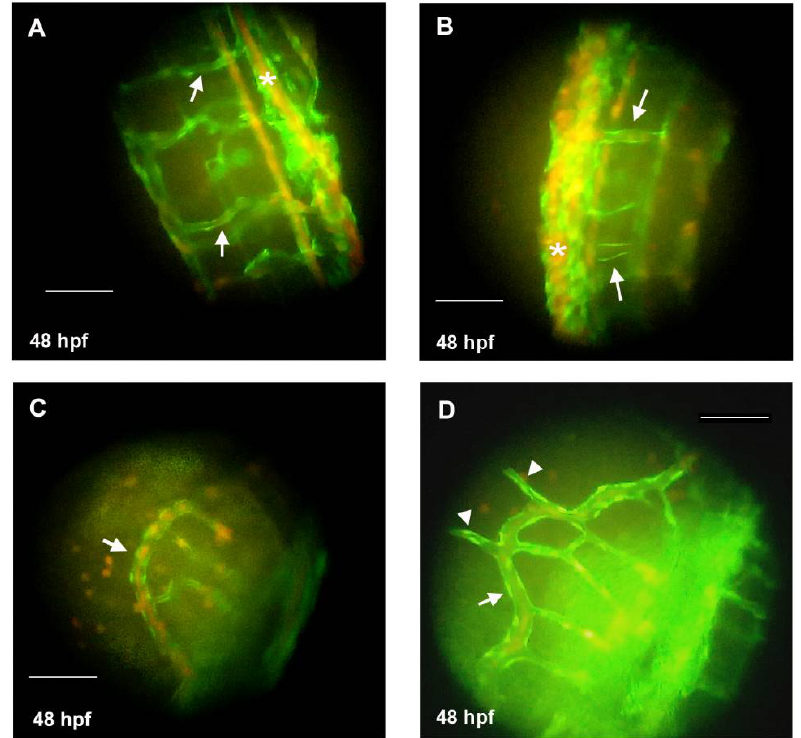
Figure 5. Knockdown of hyaluronan synthases 2 gene (HAS2) in zebrafish embryos leads to dilated venous structure. Tg ( fli1 : egfp ) xTg ( gata1 : dsRed ) zebrafish with green fluorescence emitting vasculature are used to observe the anatomic change of vasculature. ( A ) Inter-segmental veins (ISVs) in the tail of a representative wild-type zebrafish (48 hpf) under fluorescence microscope (arrows); ( B ) Dilated ISVs in the tail of a representative HAS2-morpholino (MO) injected zebrafish (48 hpf) under fluorescence microscope (arrows); ( C ) The sub-intestinal vein (SIV) in the tail of a representative wild-type zebrafish (48 hpf) under fluorescence microscope (arrow); ( D ) The dilated SIV (arrow) with protruding branches (arrowheads) in the tail of a representative HAS2-morpholino (MO) injected zebrafish (48 hpf) under fluorescence microscope. Hpf indicates hours post-fertilization. Magnification is 400×. Scale bar = 100 μm.